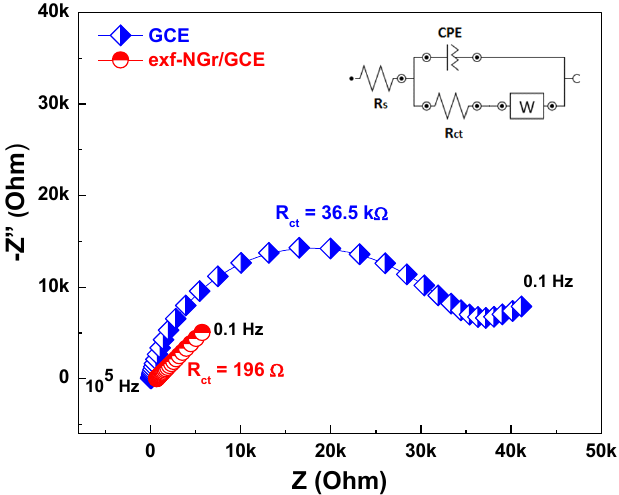
Figure 4. Nyquist plot of the bare GCE (blue curve) and exf-NGr/GCE (red curve) . Inset : The electrical equivalent circuit employed to fit the experimental results.